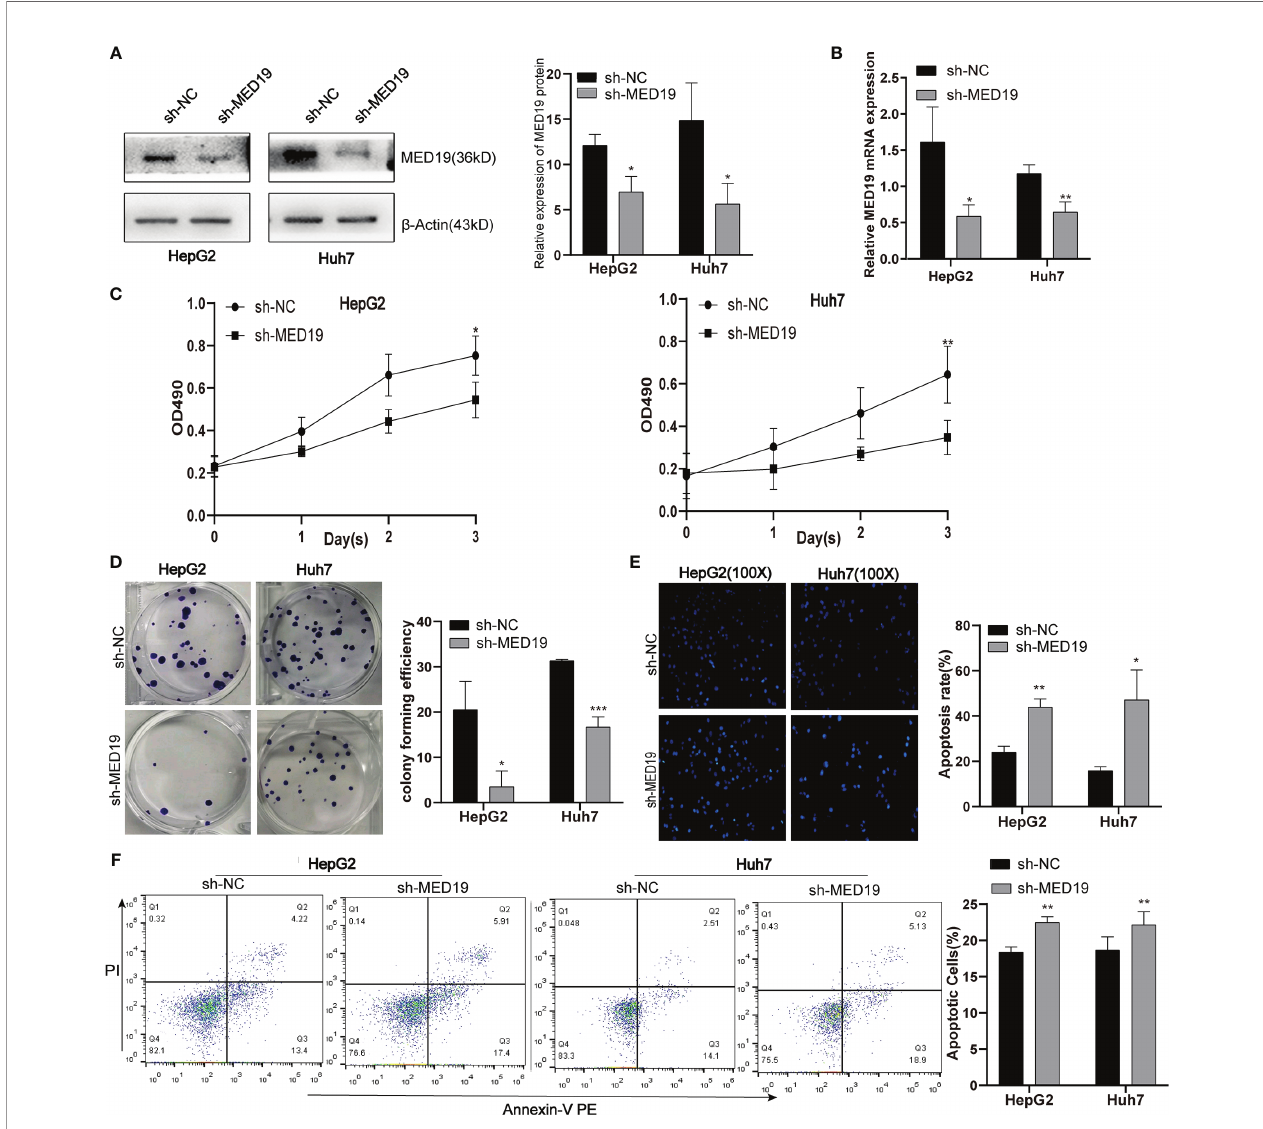
FIGURE 3 | MED19 knockdown inhibited HCC cell proliferation and promoted cell apoptosis. (A, B) Relative MED19 RNA and protein levels in HepG2 and Huh7 cells after transfection with sh- MED19 or sh-NC plasmid. (C) The viability of HepG2 and Huh7 cells in the sh- MED19 and sh-NC group. (D) In fl uence of MED19 knockdown on clone formation of HepG2 and Huh7 cells. (E) The apoptosis situation of HepG2 and Huh7 cells induced by Hoechst 33258. (F) The apoptosis situation of HepG2 and Huh7 cells by fl ow cytometry. * P < 0.05; ** P < 0.01; *** P < 0.001. Perform three independent replicates. Statistical analysis is performed using an unpaired t - test. All results are expressed as mean ±